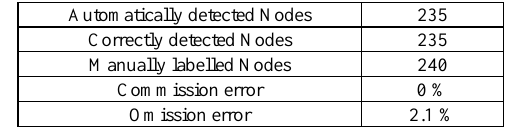
Table 1. Commission and omission errors for repeated structure